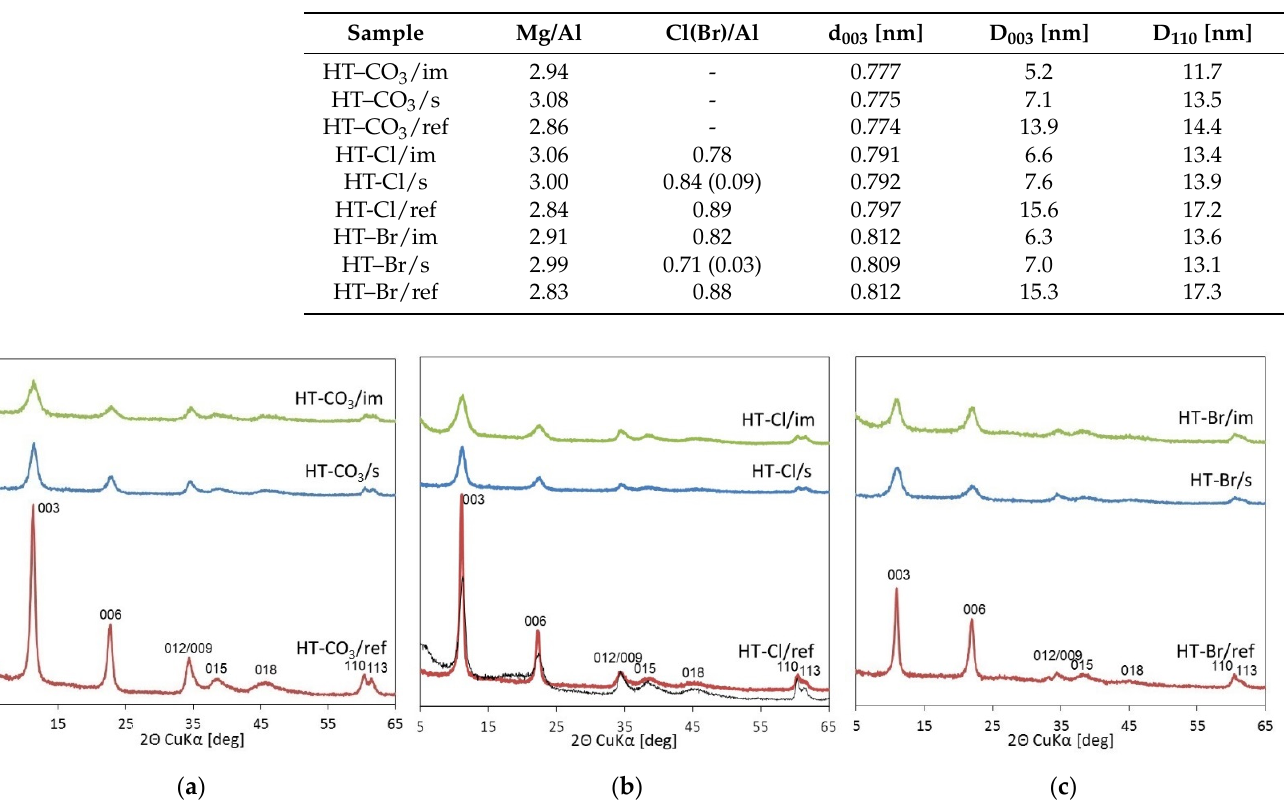
Table 1. Mg/Al ratio, Cl(Br)/Al ratio, basal spacing, and crystal sizes in the c and a direction of HT samples. In brackets, the Cl(Br)/Al ratio after reaction with added bicarbonate.